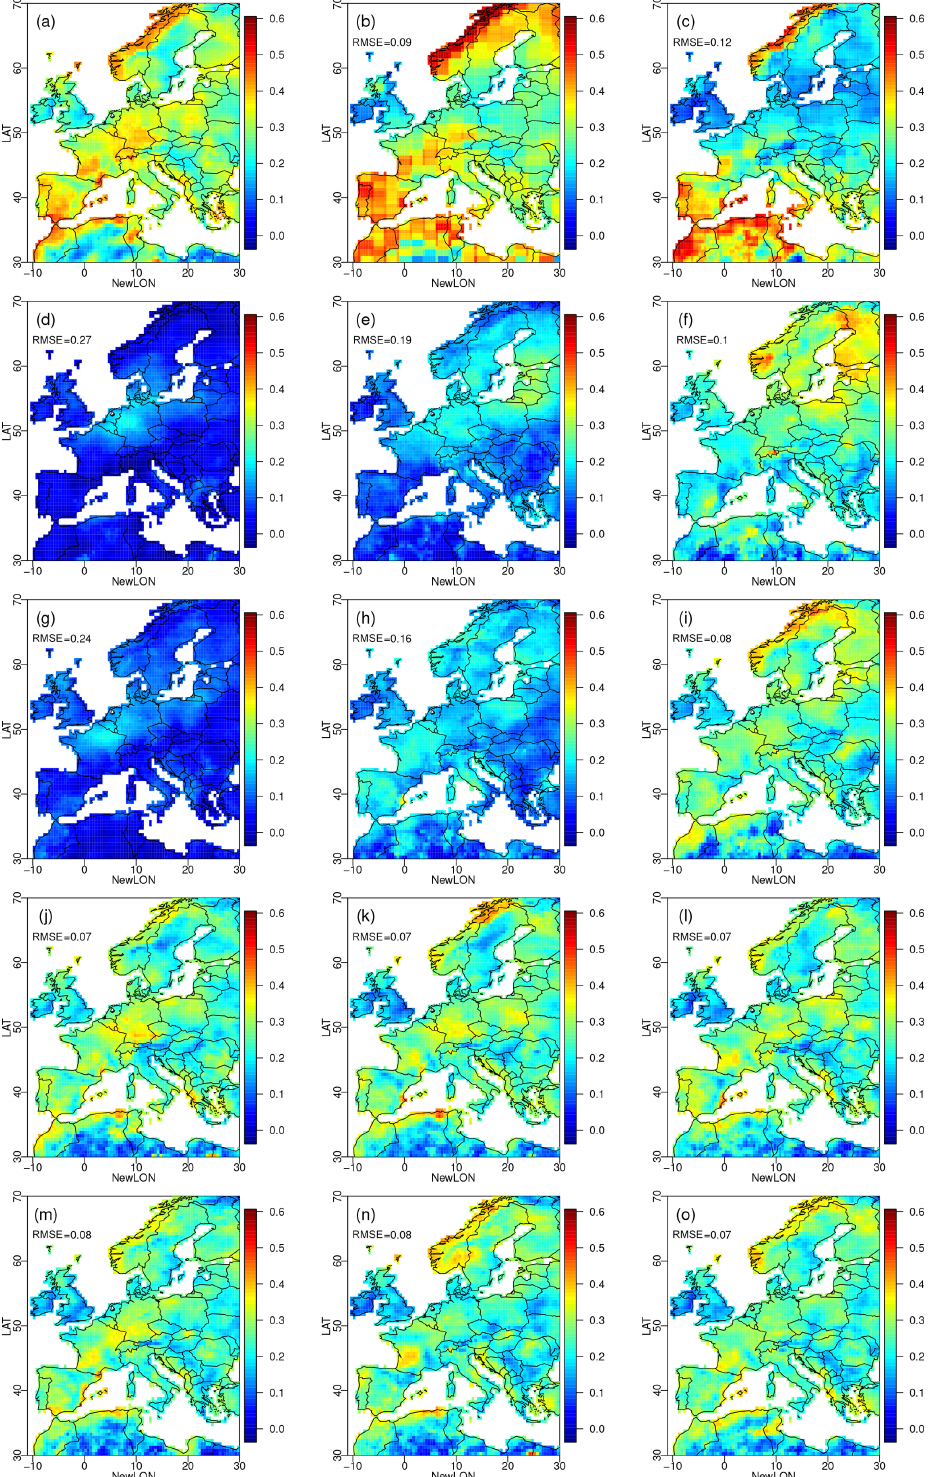
Figure 2. Same as Fig. 1 but for winter precipitation autocorrelations. Note that here precipitation is never used alone as a conditioning